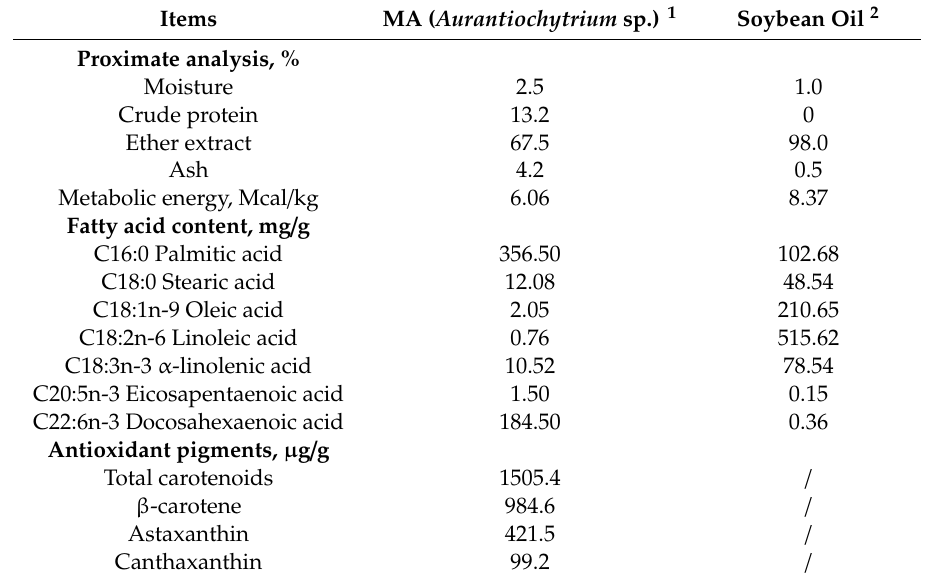
Table 1. Proximate chemical composition and fatty acid profile of microalgae ( Aurantiochytrium sp.) and soybean oil used in the present